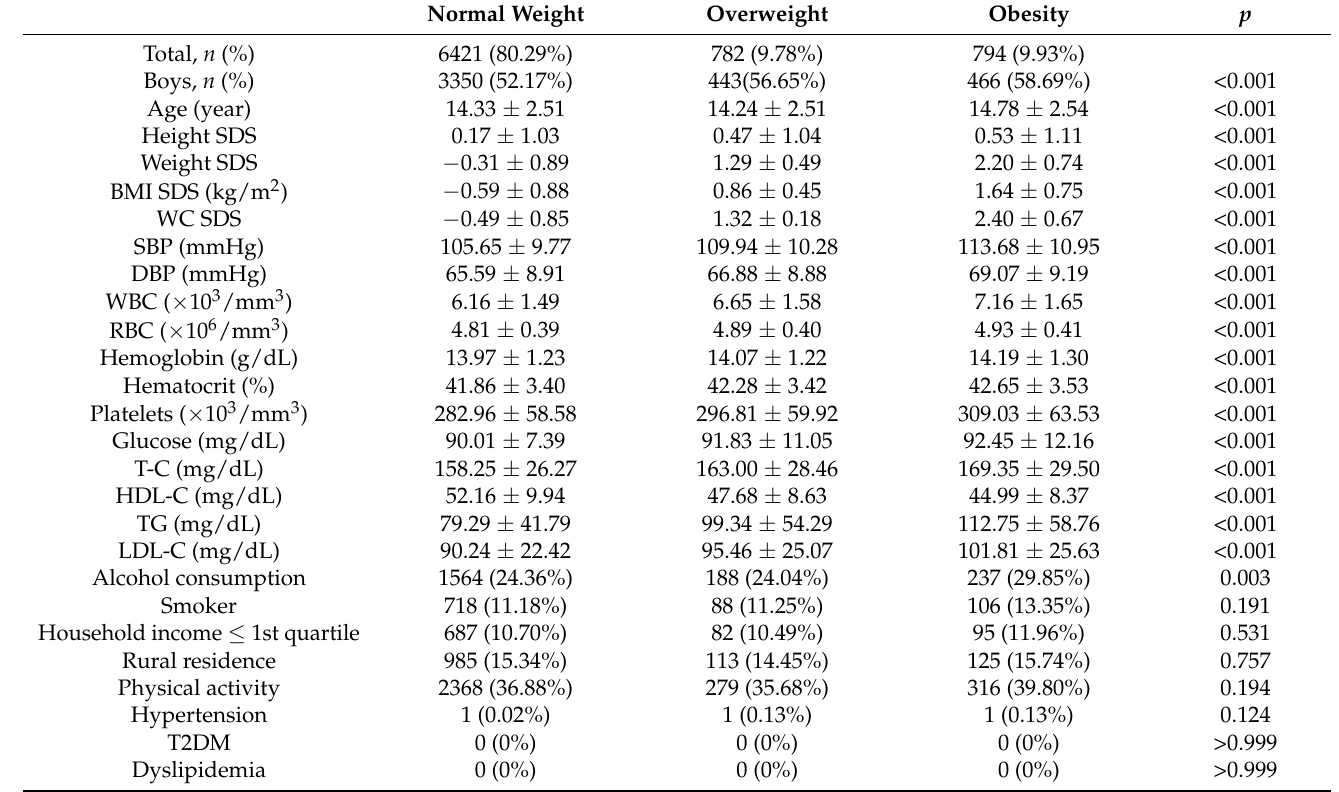
Table 1. Clinical characteristics of the study participants by body weight ( n = 7997). Normal Weight